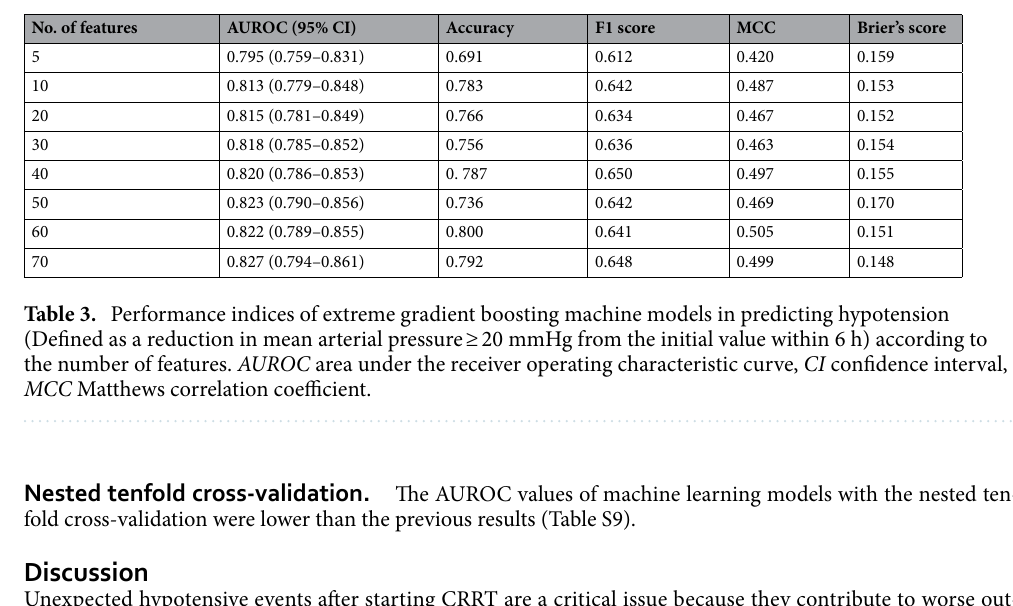
No. of features AUROC (95%